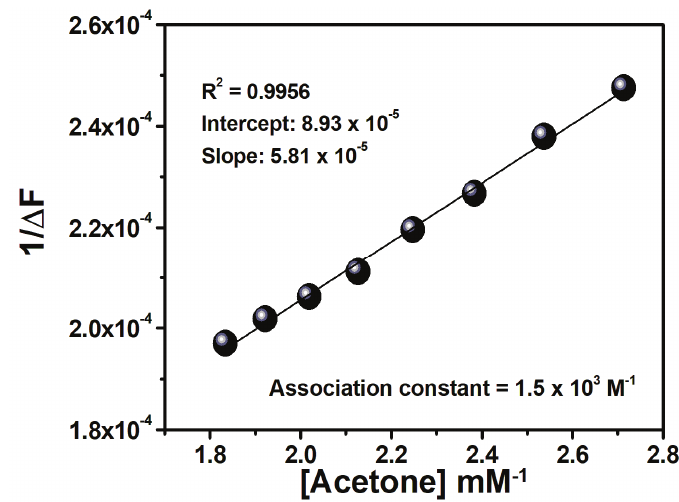
Figure 5. Double reciprocal plot for 1:1 association between complex {[Zn(bipy) 2 (H 2 O)](ClO 4 ) 2 }( 1 ) and acetone.